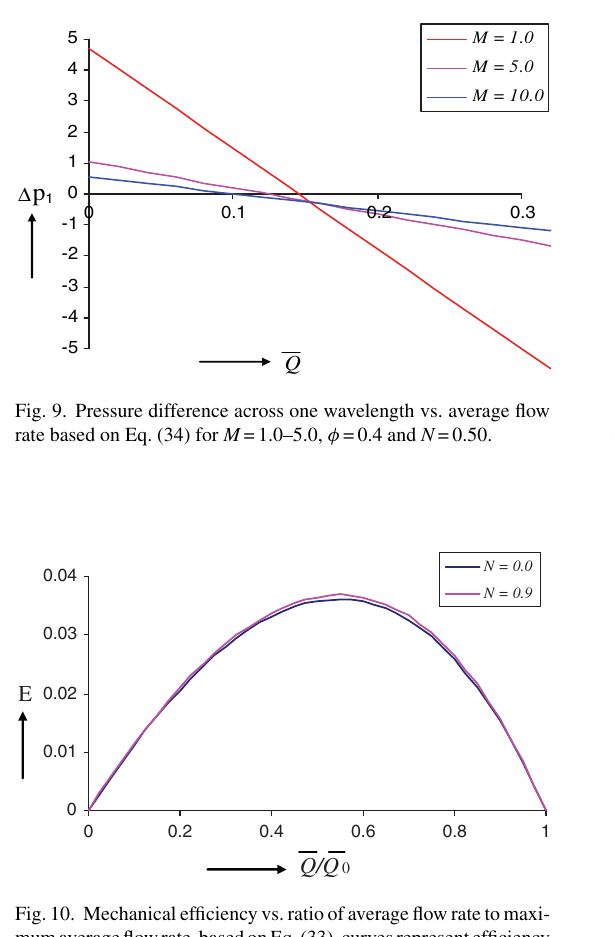
Fig. 13. Average flow rate vs. amplitude, based on Eq. (45). Curves represent reflux limit for M =0.001, 0.01, φ =0.4 and N